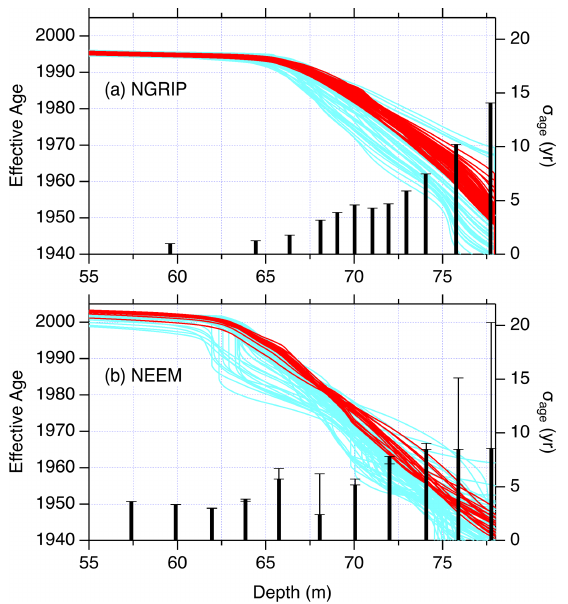
Figure 11. Depth profiles of effective age of CH 4 calculated af- ter the iterative dating calculations for depths below 55m at the (a) NGRIP and (b) NEEM firn sites (left axis). The solid lines rep- resent cases for different diffusivity profiles and are coloured in the same manner as in the earlier figures. Vertical bars in black indicate the spread of the effective age ( σ age ; maximum minus minimum) at the individual sampling depths among the modelling cases in red (right axis). For the NEEM firn, the thin vertical bars correspond to the spread for simulation cases in which 14 CO 2 data are excluded for evaluations of the diffusivity